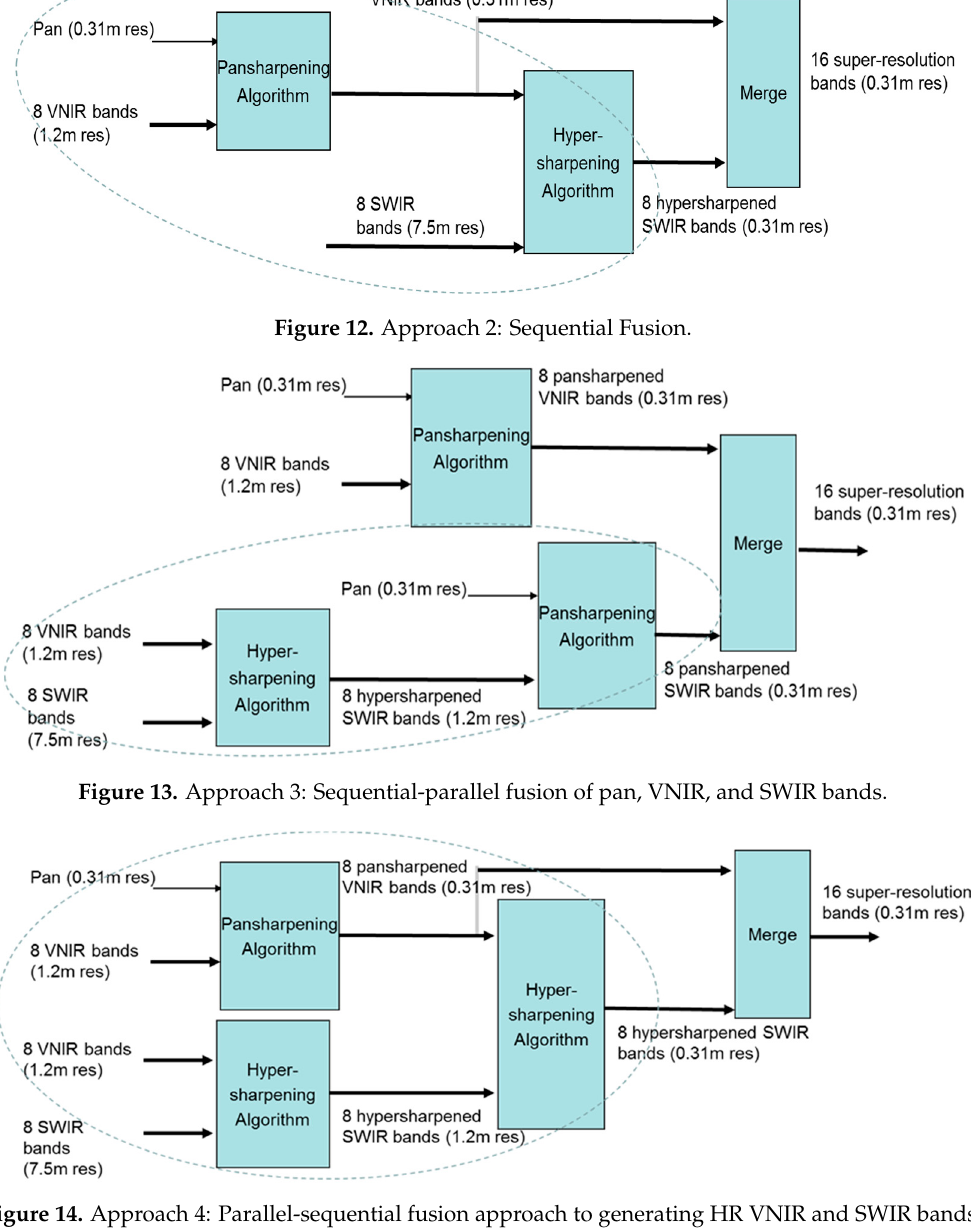
Figure 14. Approach 4: Parallel-sequential fusion approach to generating HR VNIR and SWIR bands.